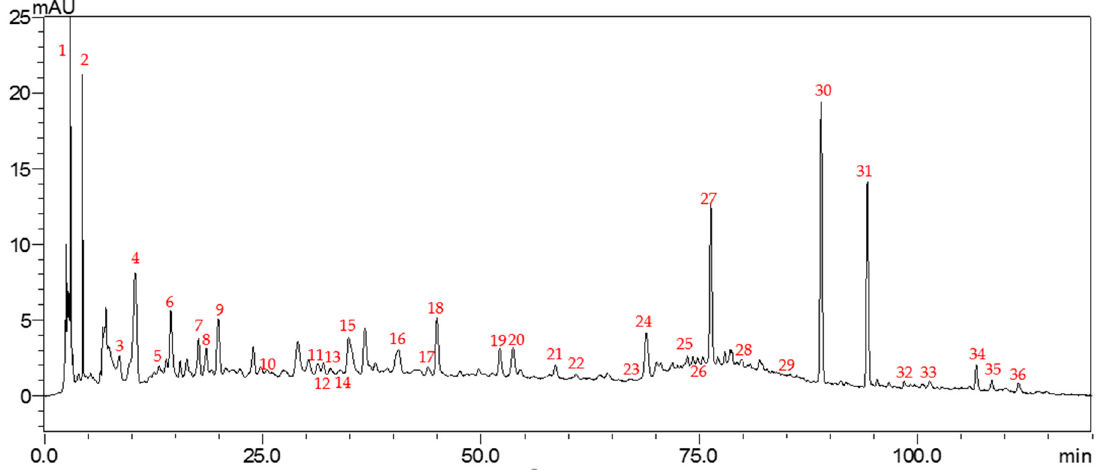
Figure 4. HPLC chromatogram of the fruit of C. fistula .